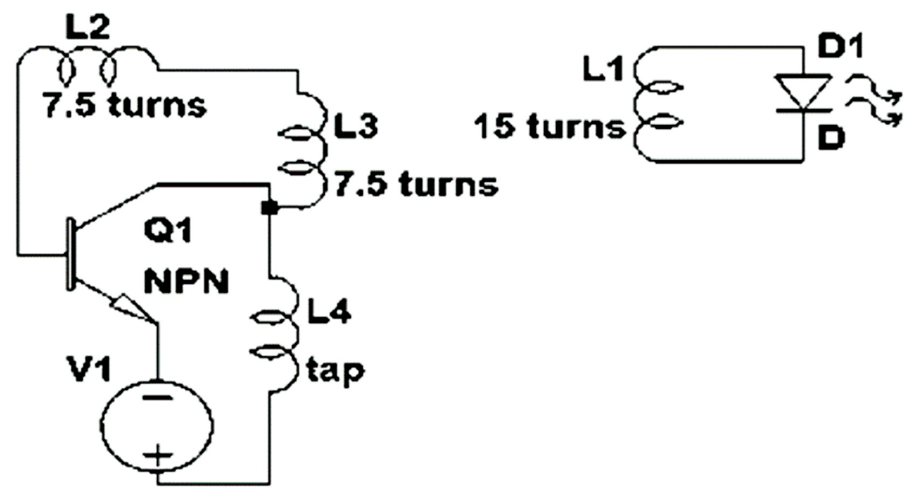
Figure 2. Magnetic resonance coupling circuit.